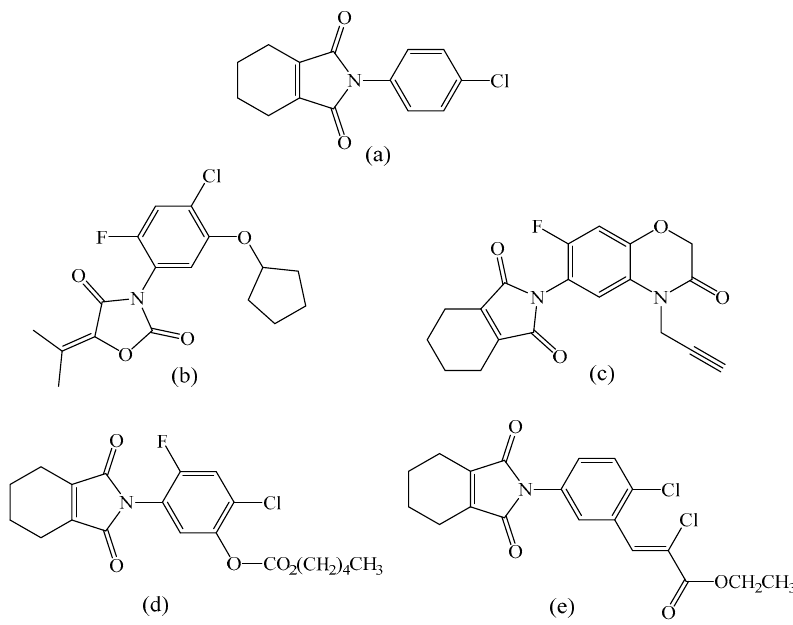
Figure 1. Commercial herbicides containing cyclic imides in their structures ( a ) chlorphthalim, ( b ) pentoxazone, ( c ) flumioxazin, ( d ) flumiclorac-pentyl, and ( e ) cinidon-ethyl.